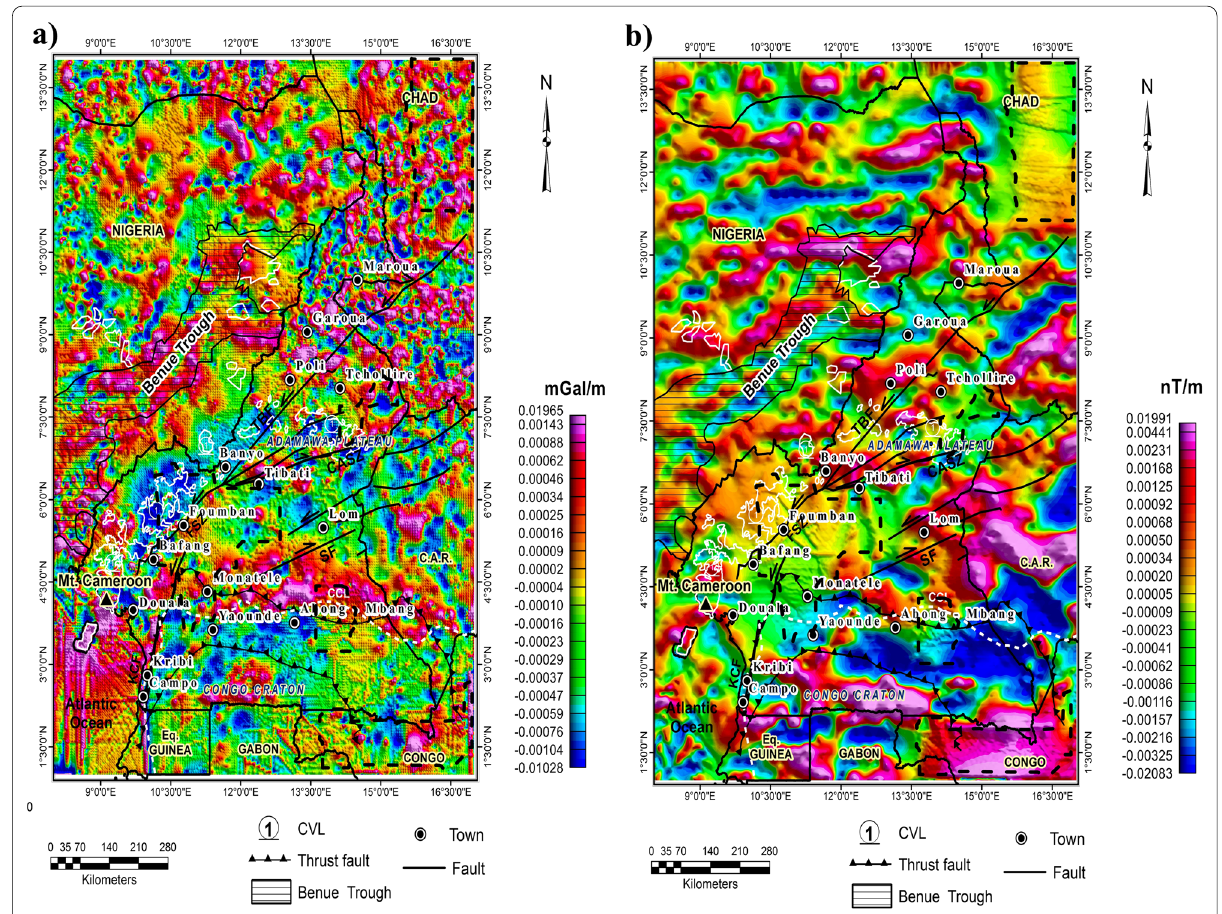
Fig. 6 Vertical gradient Map of: a Bouguer anomalies and b